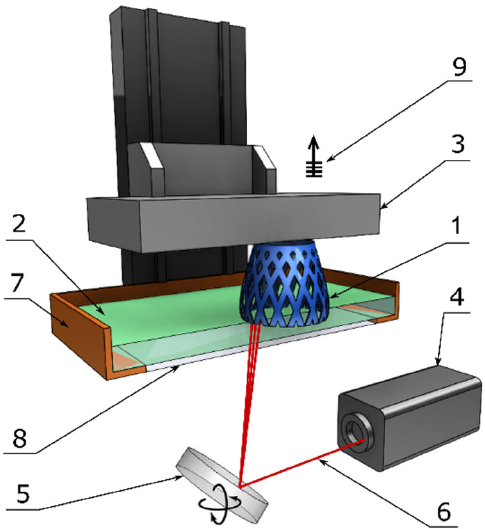
Figure 5. Components of a typical SLA machine: 1—printed part, 2—liquid resin, 3—building platform, 4—UV laser source, 5—XY scanning mirror, 6—laser beam, 7—resin tank, 8—window, and 9—layer-by-layer elevation.